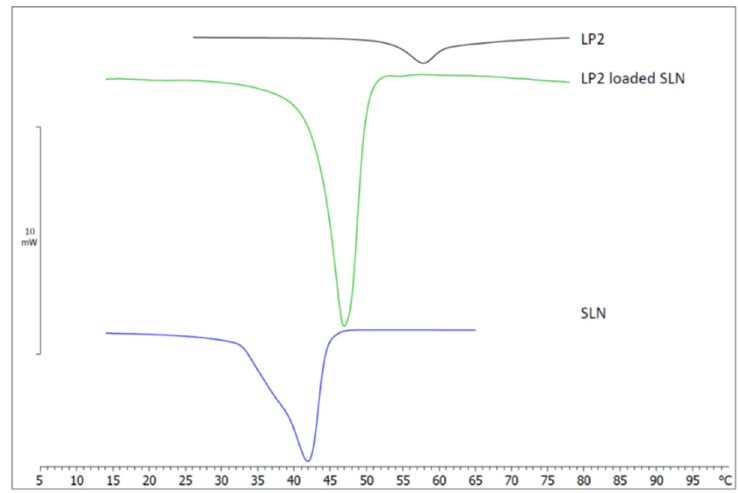
Figure 2. Calorimetric curves of LP2, unloaded solid lipid nanoparticles (SLNs), and LP2-loaded solid lipid nanoparticles (LP2-loaded SLNs).